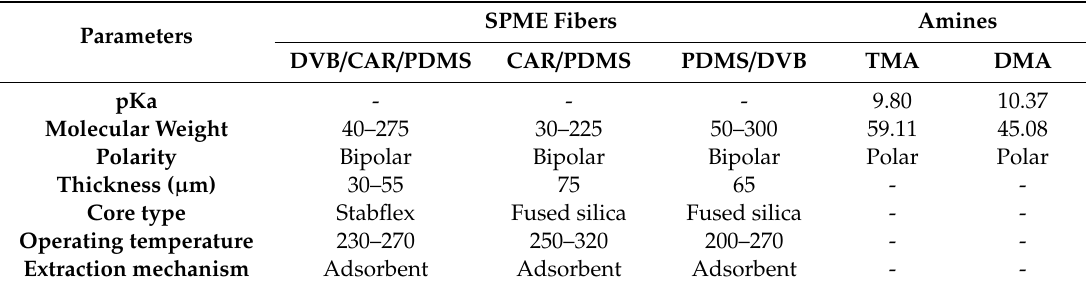
Table 1. Some characteristics of SPME fibers and targeted volatile